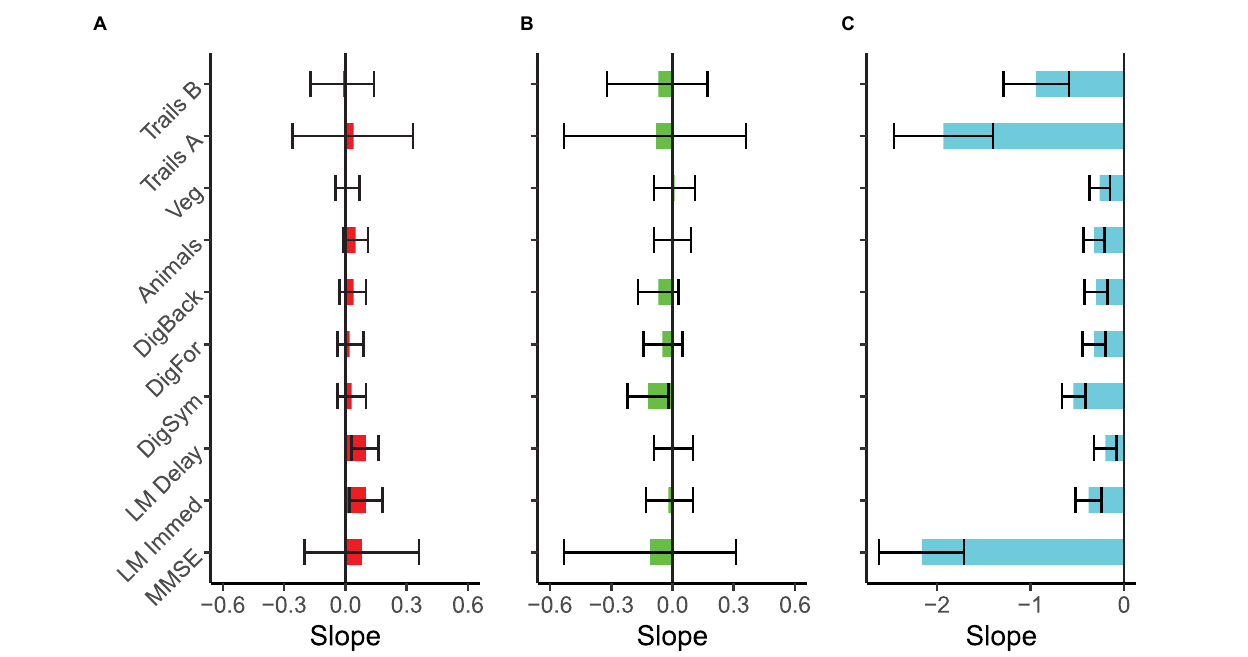
FIGURE 3 | Slope estimates and 95% confidence intervals for each test and clinical group in the DIAN-Observational (DIAN-Obs) study. Slopes are expressed as z-score units change per year and can be considered significant if the CI does not encompass zero. All tests were scaled such that a negative slope indicates decline. (A) Plots non-carriers ( N = 115), (B) plots CDR 0 mutation carriers ( N = 35), and (C) plots CDR > 0 mutation carriers ( N = 34). Due to dramatic performance differences across groups, the X-axis scale is not identical across the